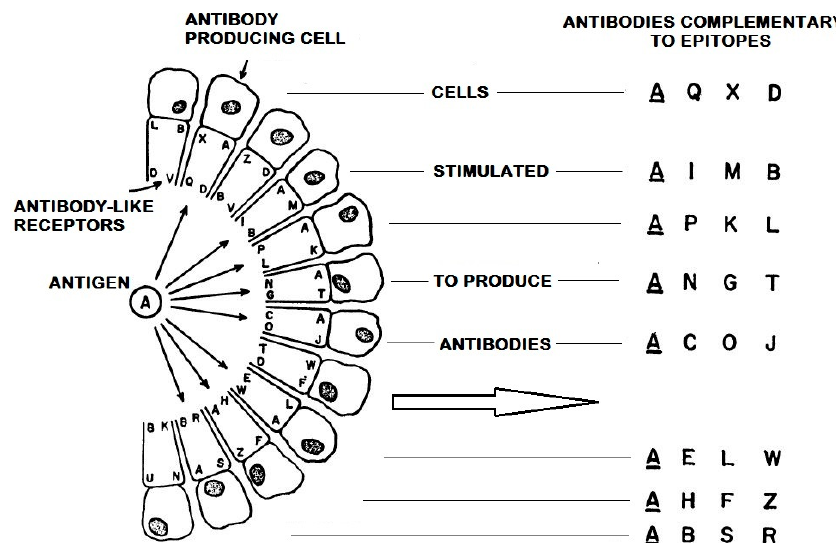
Figure 4 . Immune serum specificity as a population phenomenon. Individual B cell receptors are shown as having properties similar to immunoglobulin combining regions. For illustrative purposes, these are drawn as being each complementary to four different epitopes or antigens; we suppose that this number is in fact much larger. Stimulation by antigen A causes the cells with A specificity to divide and produce antibodies directed against A. The immune serum produced will therefore react in high titer with antigen A. Each produced immunoglobulin also has other specificities, but because these need not be the same in every molecule, the other specificities, B to Z, will be diluted out and will react only in low titer (from Richards et al., 1975 [182]).